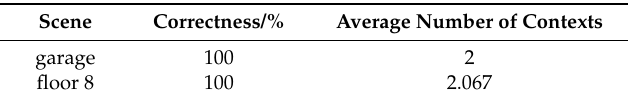
Table 3. The results of finding the starting